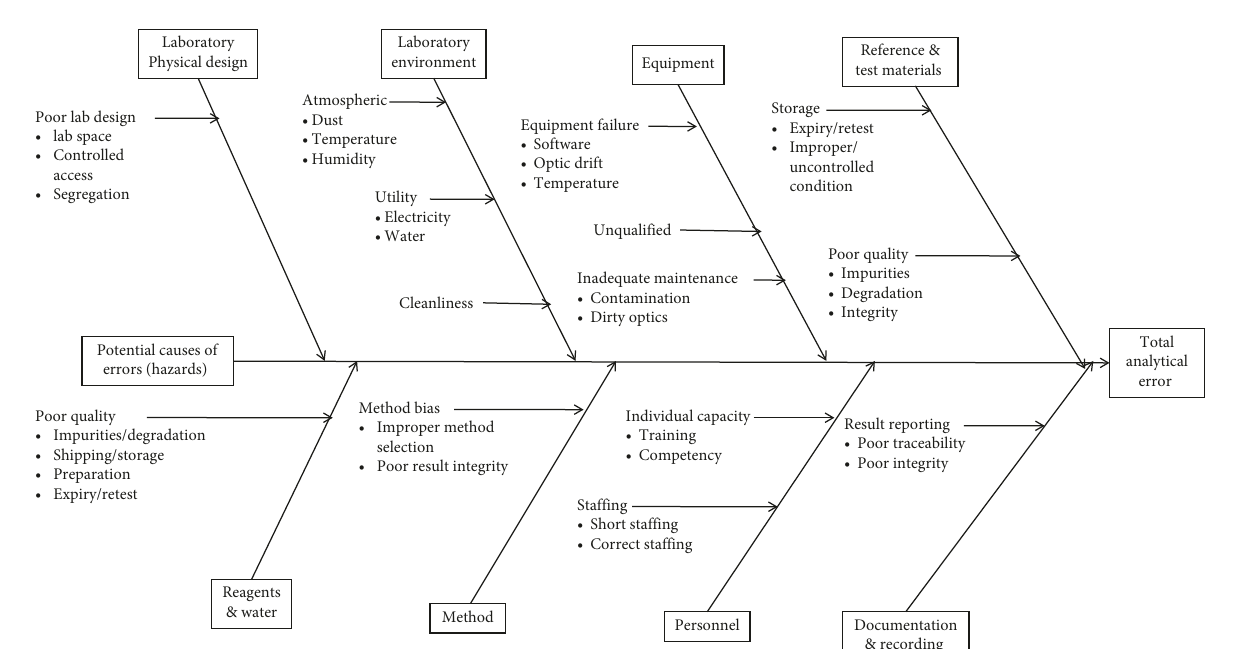
Figure 1: Ishikawa diagram for risk assessment in JuLaDQ